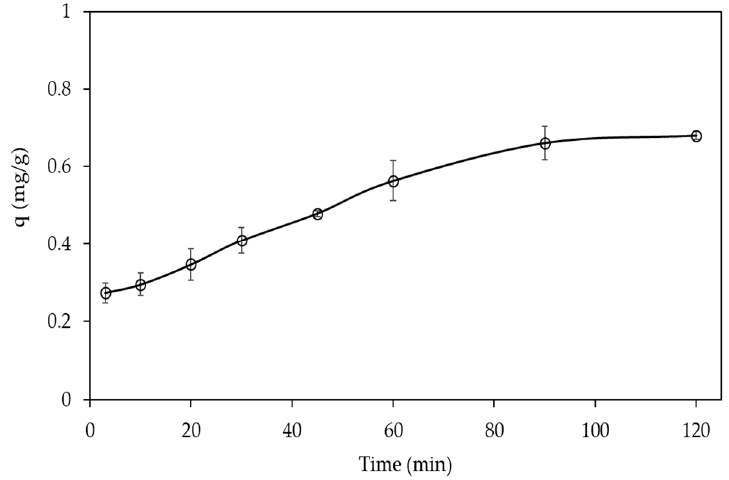
Figure 4. Mass of adsorbed cisplatin (mg)/mass of adsorbent (g) vs. contact time.